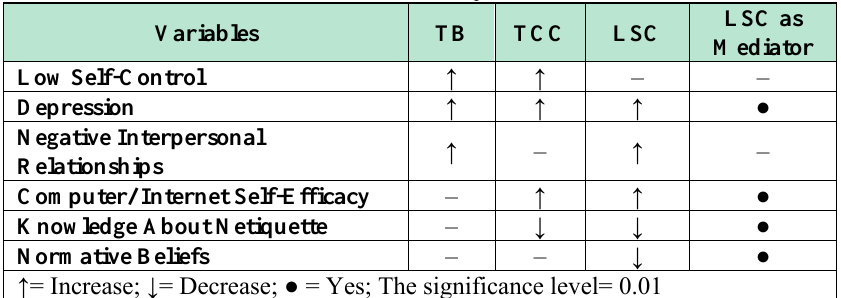
Table 4: The Effects of Examined Cyber Social Control